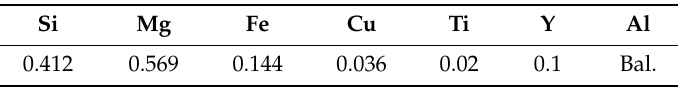
Table 1. Chemical composition of the studied alloy (wt %) Si Mg Fe Cu Ti Y Al